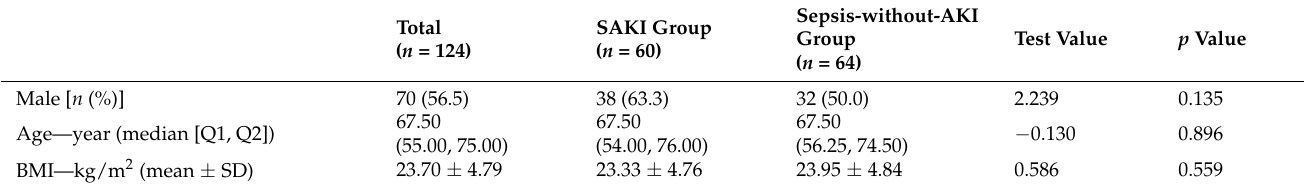
Table 1. Comparison of clinical characteristics between SAKI and sepsis-without-AKI